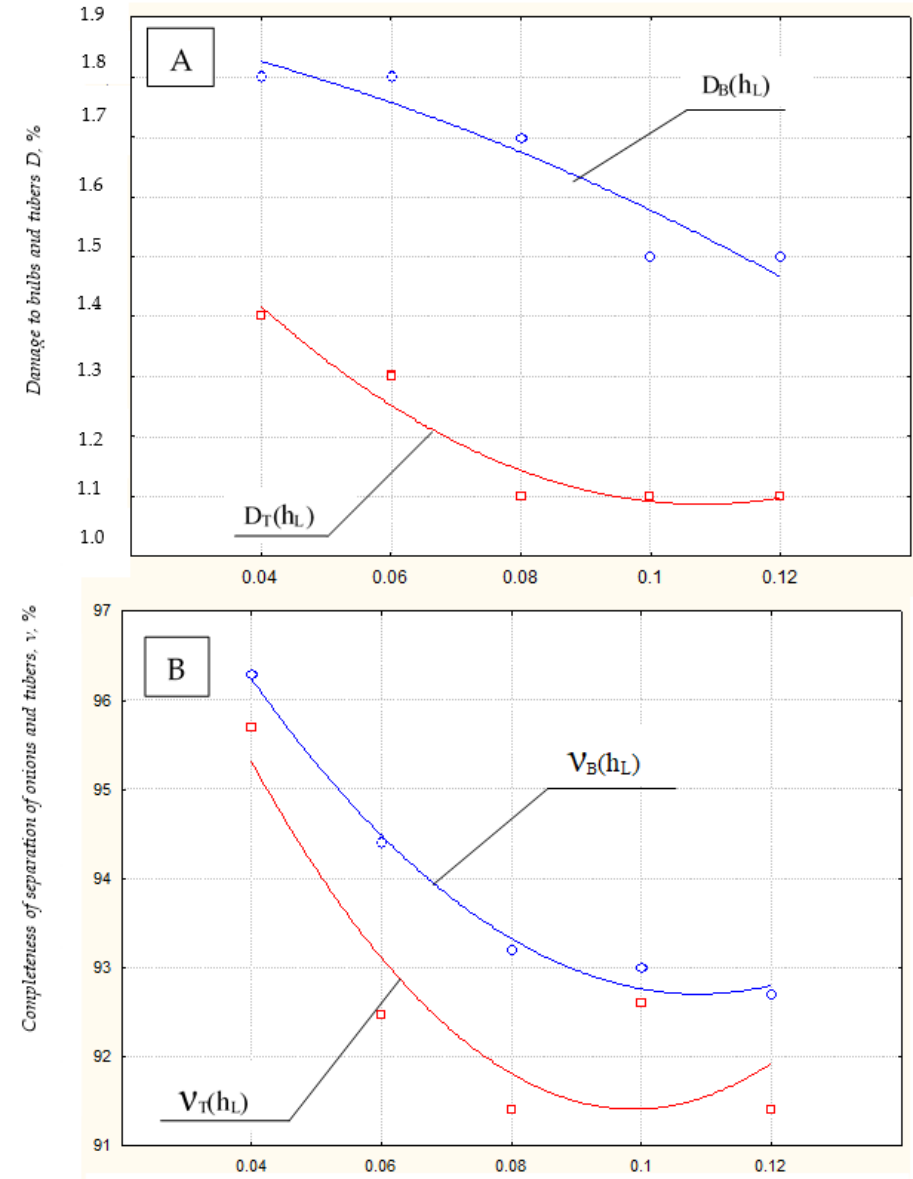
Figure 7. Dependence of: ( A ) damage to bulbs D B and tubers D T %; and ( B ) completeness of separation of onions ν B and tubers ν T % of the separating rod elevator with an adjustable blade inclination angle from the depth h L of digging share into the